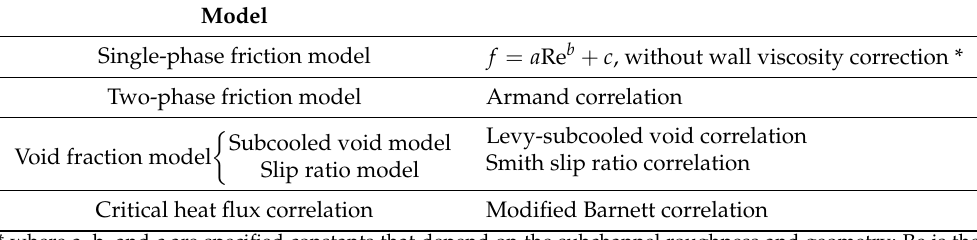
Table 1. Basic thermal–hydraulic models used in the COBRA code. Model Single-phase friction model Two-phase friction model (cid:26) Levy-subcooled void Subcooled void model Void fraction model Slip ratio model